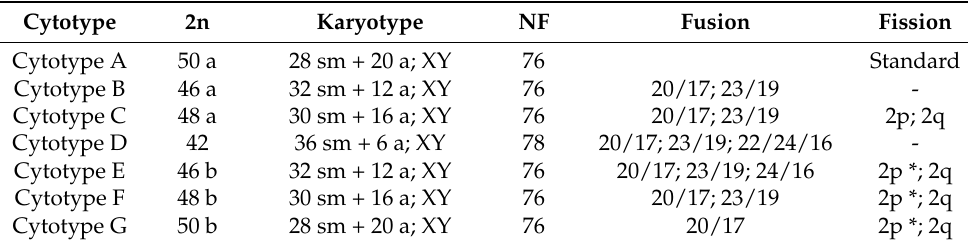
Table 1. Karyotype data with respective cytotype, diploid number (2n), karyotype, Fundamental Number (NF), and the main rearrangements involved in their differentiation.